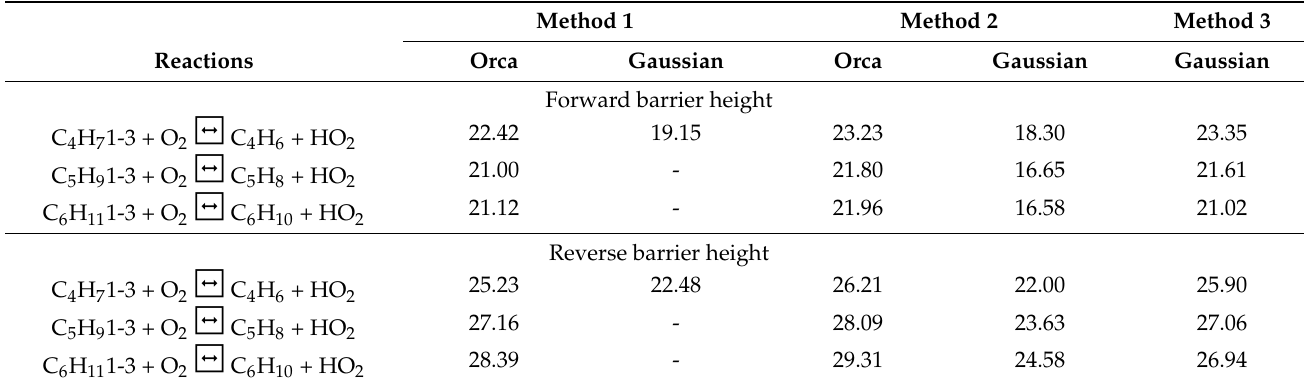
Table 3. Comparison of barrier heights. (Unit: kcal/mol).